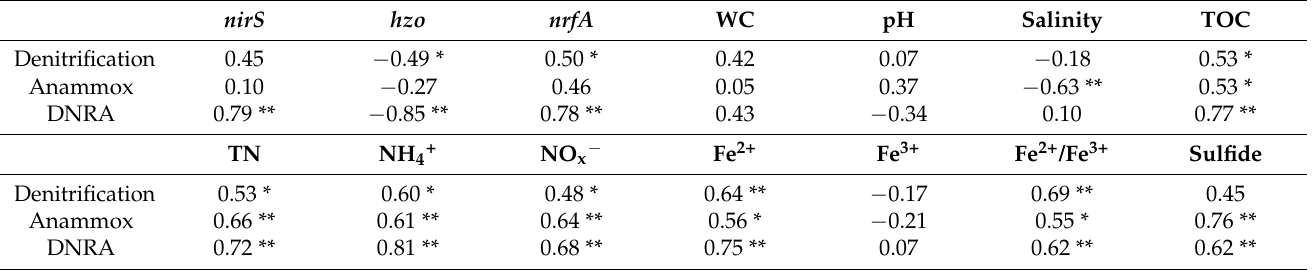
Table 3. The relationships between NO 3 − reduction rates with relevant gene abundance and physico-chemical properties.